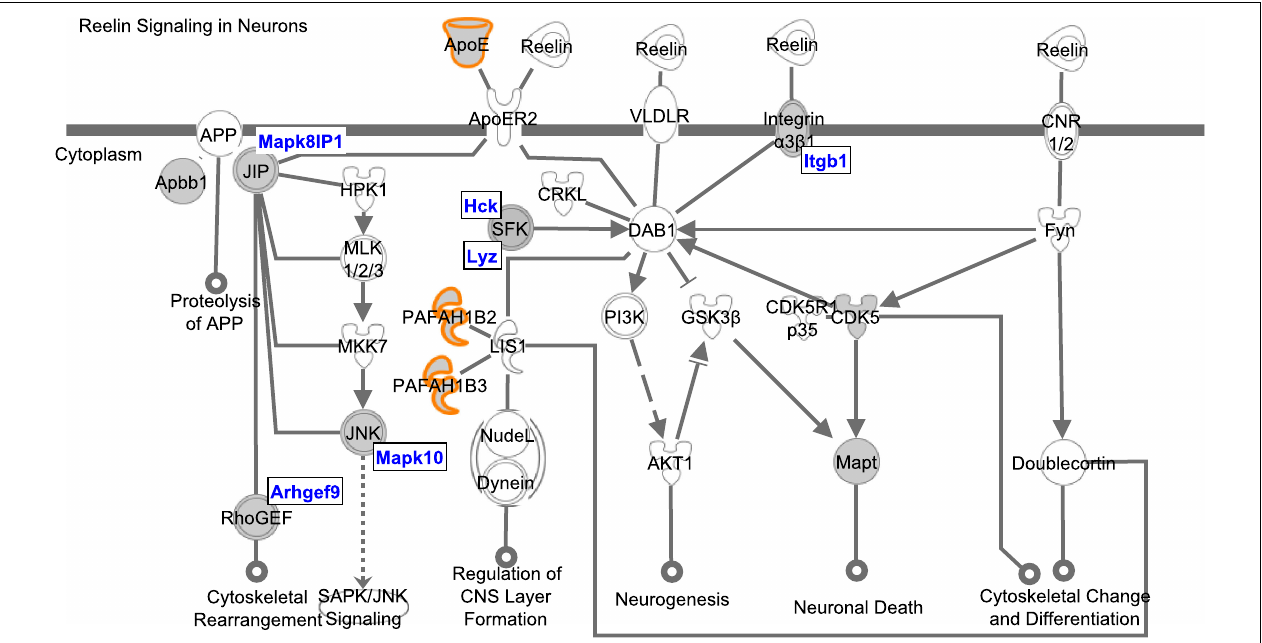
FIGURE 3 | Depiction of the “Reelin signalling in neurons” pathway generated by Ingenuity. The genes and complexes (double lines) highlighted in grey are form 24-h gene set and the genes outlined in orange are also in the reference set. The genes from the 24-h list that are components of complexes are highlighted in blue.